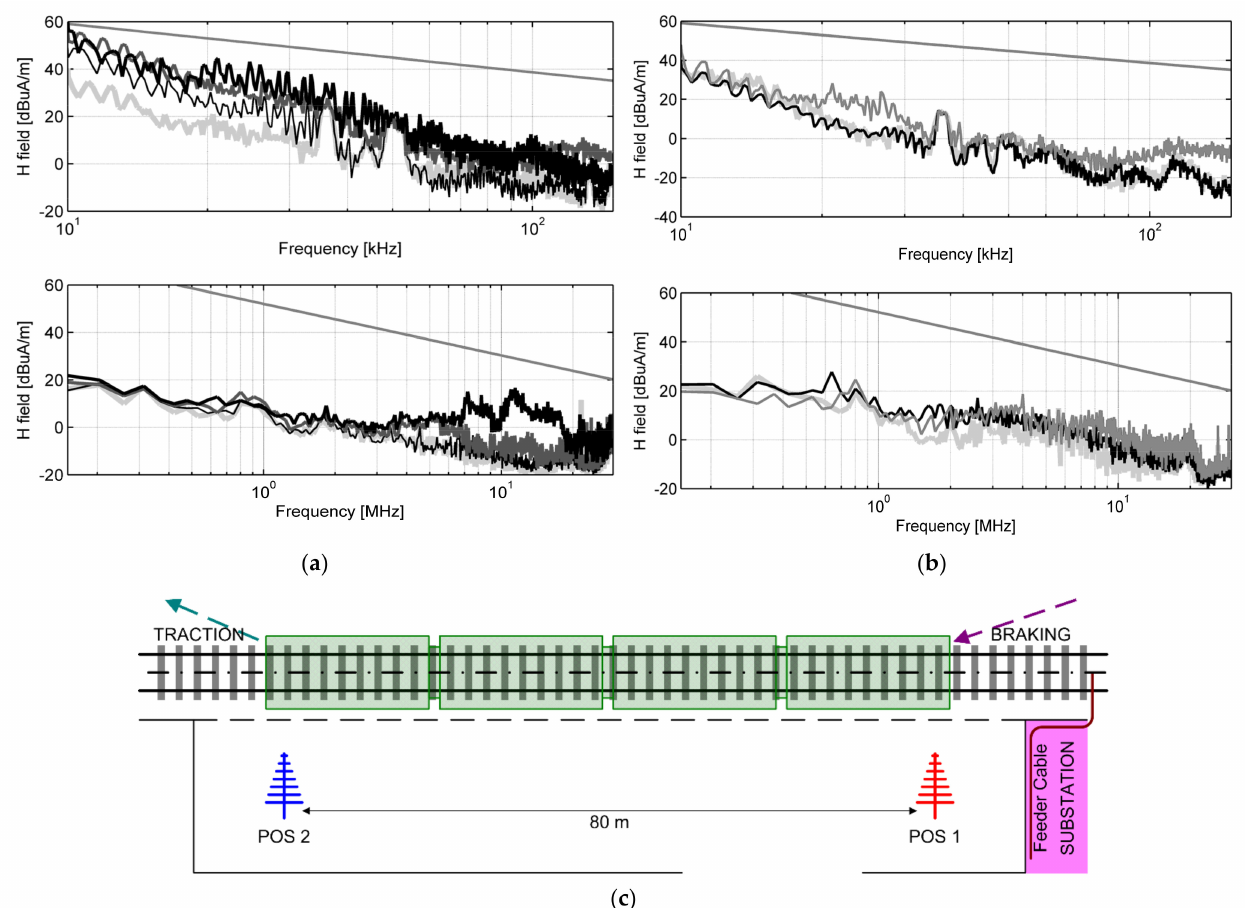
Figure 7. Measurement of train in commercial service: ( a ) pos. 2 (left platform end) and ( b ) pos. 1 (left platform end); distance between pos. 1 and 2 about 80 m. Operating conditions: background (light grey), braking (dark grey), coasting (thin black), and traction (thick black). ( c ) sketch of platform, measurement positions, braking/traction phase, and feeder cable from substation to